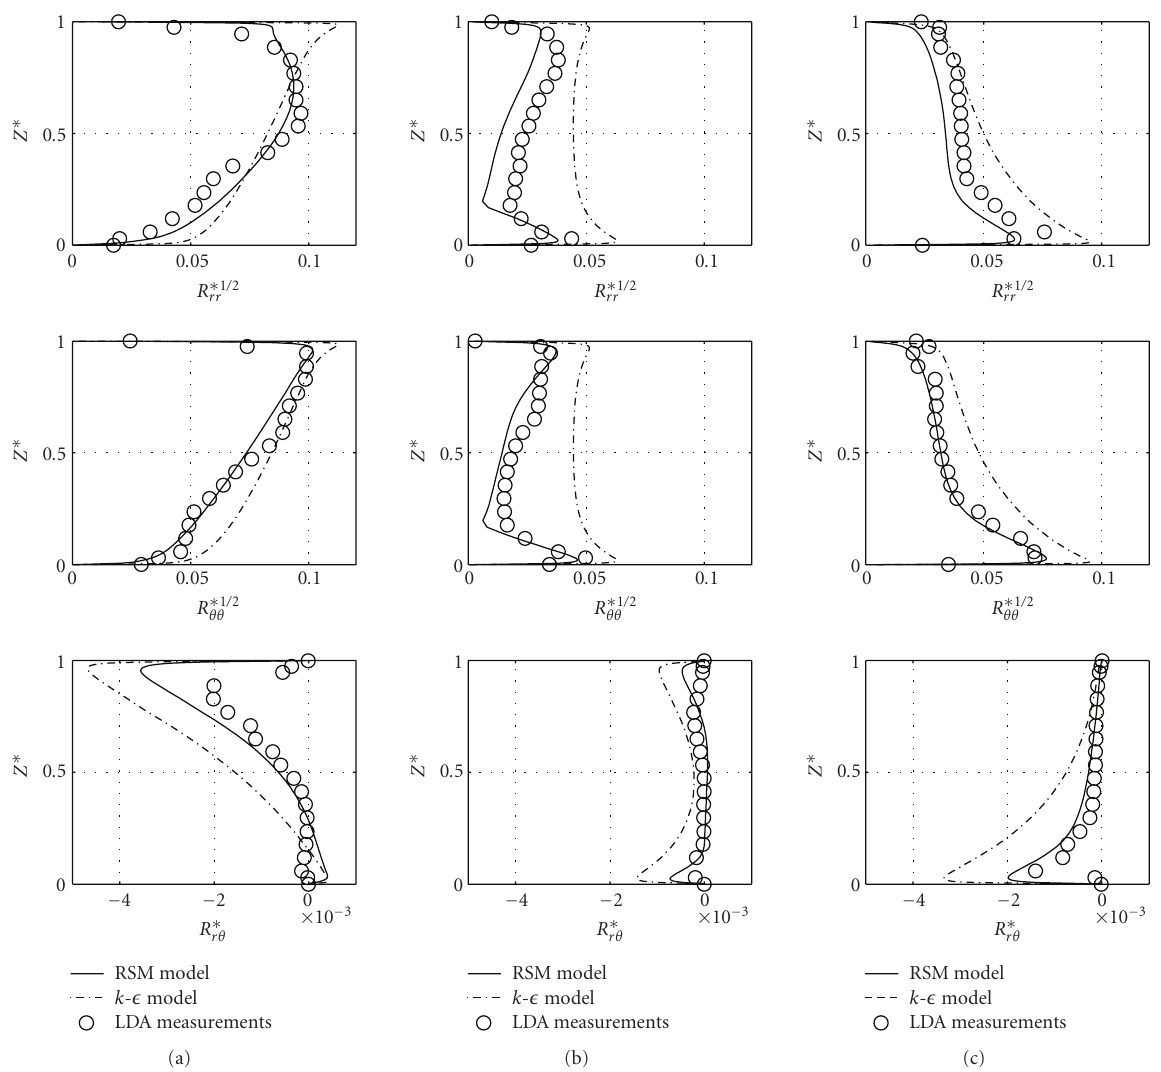
Figure 5: Axial profiles of three Reynolds stress tensor components at r ∗ = 0 . 56 for G = 0 . 036 and Re = 10 6 : (a) C w = 9881, (b) C w = 0, (c) C w = − 9881. Comparisons between the present RSM model ( − ), the k - (cid:2) model ( −·− ), and LDA measurements ( ◦